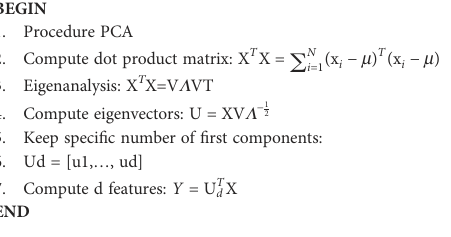
ALGORITHM 5 Principal Component